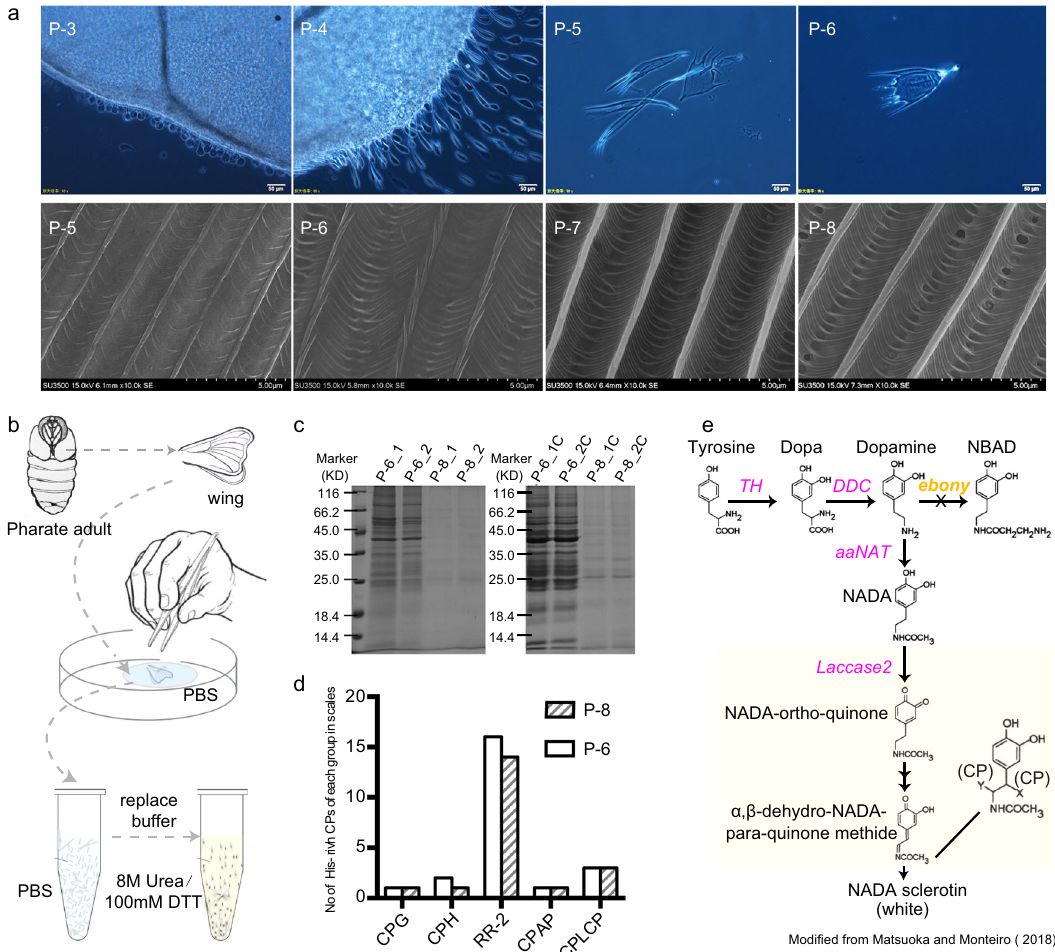
Fig. 1 Development, structural components, and related enzymes of wing scales. a Development of wing scales. Upper panels: light microscopic images showing development of scales on pupal/pharate adult wings. Scale bar = 50 μ m; Lower panels: scanning electron microscopic images of isolated wing scales at various pupal/pharate adult stages. Scale bar = 5 μ m. b Schematic diagram of the isolation of CPs in pupal wing scales of P-6 and P-8 pupae. The detailed procedure is presented in Supplementary Fig. 1. c SDS-PAGE gel of proteins extracted from isolated wing scales of P-6 and P-8. Duplicate wing scale samples were solubilized fi rst in 8 M Urea/100 mM DTT, and then proteins from pellets were solubilized in SDT buffer with ultrasonic treatment. Lanes: P-6/8-1 and P-6/8-2, supernatant of P-6/8 wing scales solubilized in 8 M urea/100 mM DTT; P-6/8-1C and P-6/8-2C, pellets from P-6/8 wing scales from fi rst treatment, followed by suspension in SDT buffer and ultrasonic treatment. d Number of His-rich CPs in each CP group from wing scales in P-6 and P-8. e Cuticular sclerotization pathway. Enzymes identi fi ed by LC-MS/MS are colored magenta. Ebony (yellow) was not detected in the wing scales of B. mori